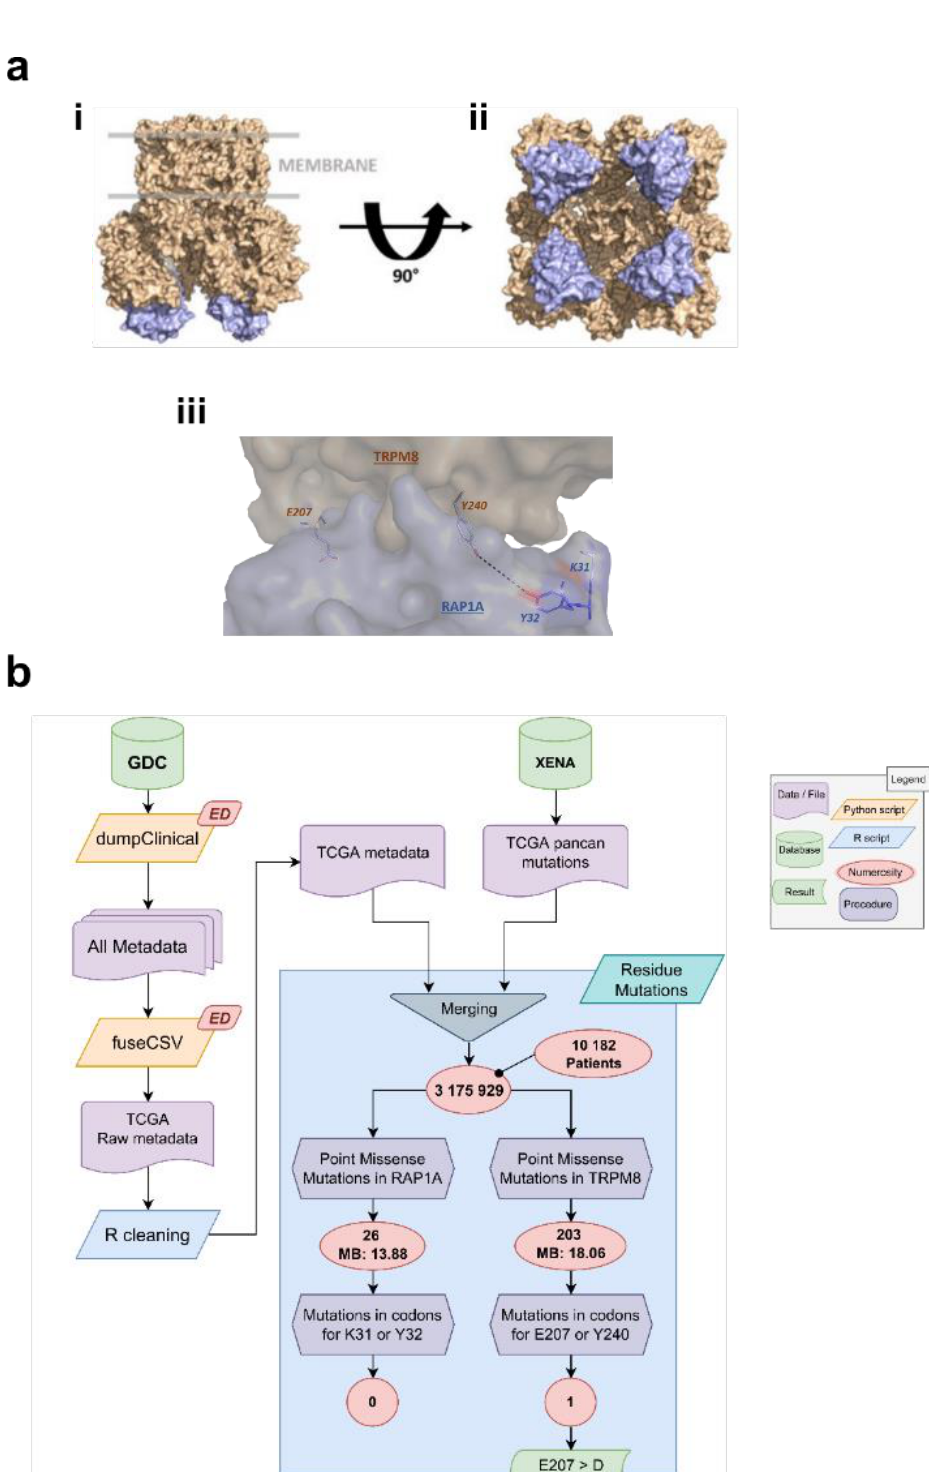
Figure 4. Identification of the residues involved in TRPM8-Rap1 interaction. ( ai ) Model of the interaction between TRPM8 (brown surface) and Rap1A (blue surface) obtained after docking simulation. ( aii ) 90° rotation view of the same model showing the tetrameric form of the TRPM8 receptor and the four interacting Rap1 proteins. ( aiii ) Focus on residues identified as hotspots after the residue centrality analysis performed on the best docking poses 3.4. ( b ) Workflow followed to investigate the presence of point mutations relative to residues identified by molecular modeling in real patients ( n = 10,182).